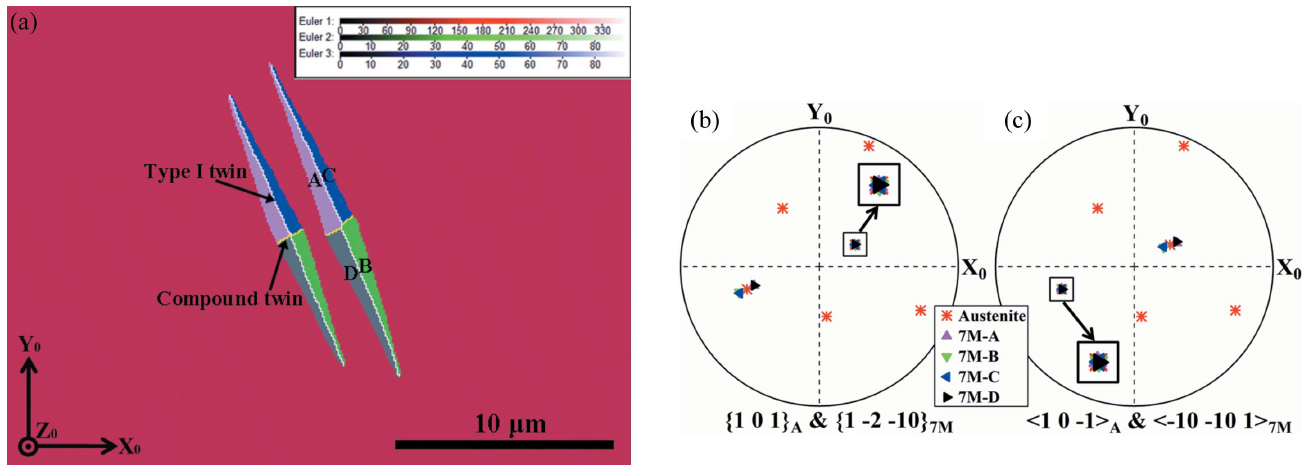
Figure 3 ( a ) An EBSD ‘all Euler’ orientation micrograph of diamond-shaped 7M martensite with four distinct variants (A, B, C and D) in austenite. The inset shows the legends of the Euler angles. ( b ) {1 0 1} A and {1 (cid:5) 2 (cid:5) 10} 7M pole figures and ( c ) h 1 0 (cid:5) 1 i A and h(cid:5) 10 (cid:5) 10 1 i 7M pole figures of austenite and 7M martensite. The common poles are highlighted by squares in the